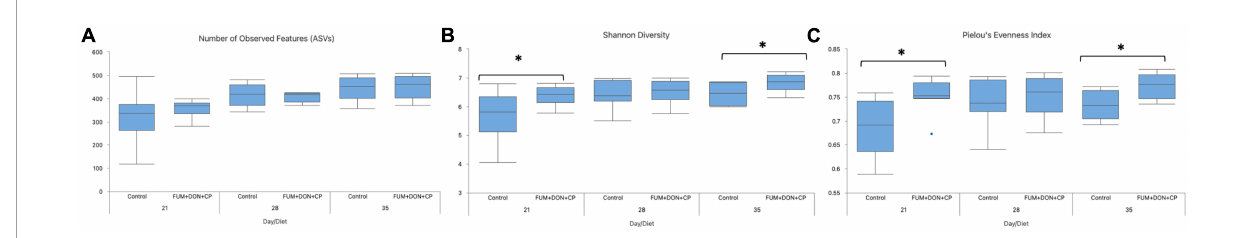
FIGURE6 Effect of subclinical fumonisins (FUM) and deoxynivalenol (DON) contamination on Alpha-Diversity indexes: Number of observed features (A) , Shannon diversity (B) , and Pielou’s evenness index (C) . Broilers were fed control or mycotoxin (FUM 3 mg/kg diet + DON 4 mg/kg diet). All birds received 1 × 10 8 CFU/bird of C. perfringens on d 19 and 20. Cecal digesta was analyzed for microbiome composition using 16S rRNA sequencing at 1, 7, and 14 days post-infection. Significance of day for number of observed features ( P < 0.001), Shannon diversity ( P = 0.02), Pielou’s evenness ( P = 0.29). Significance of diet for number of observed features ( P = 0.85), Shannon diversity ( P = 0.04), Pielou’s evenness ( P = 0.003). Asterisks denote significant difference ( ∗ P < 0.05).